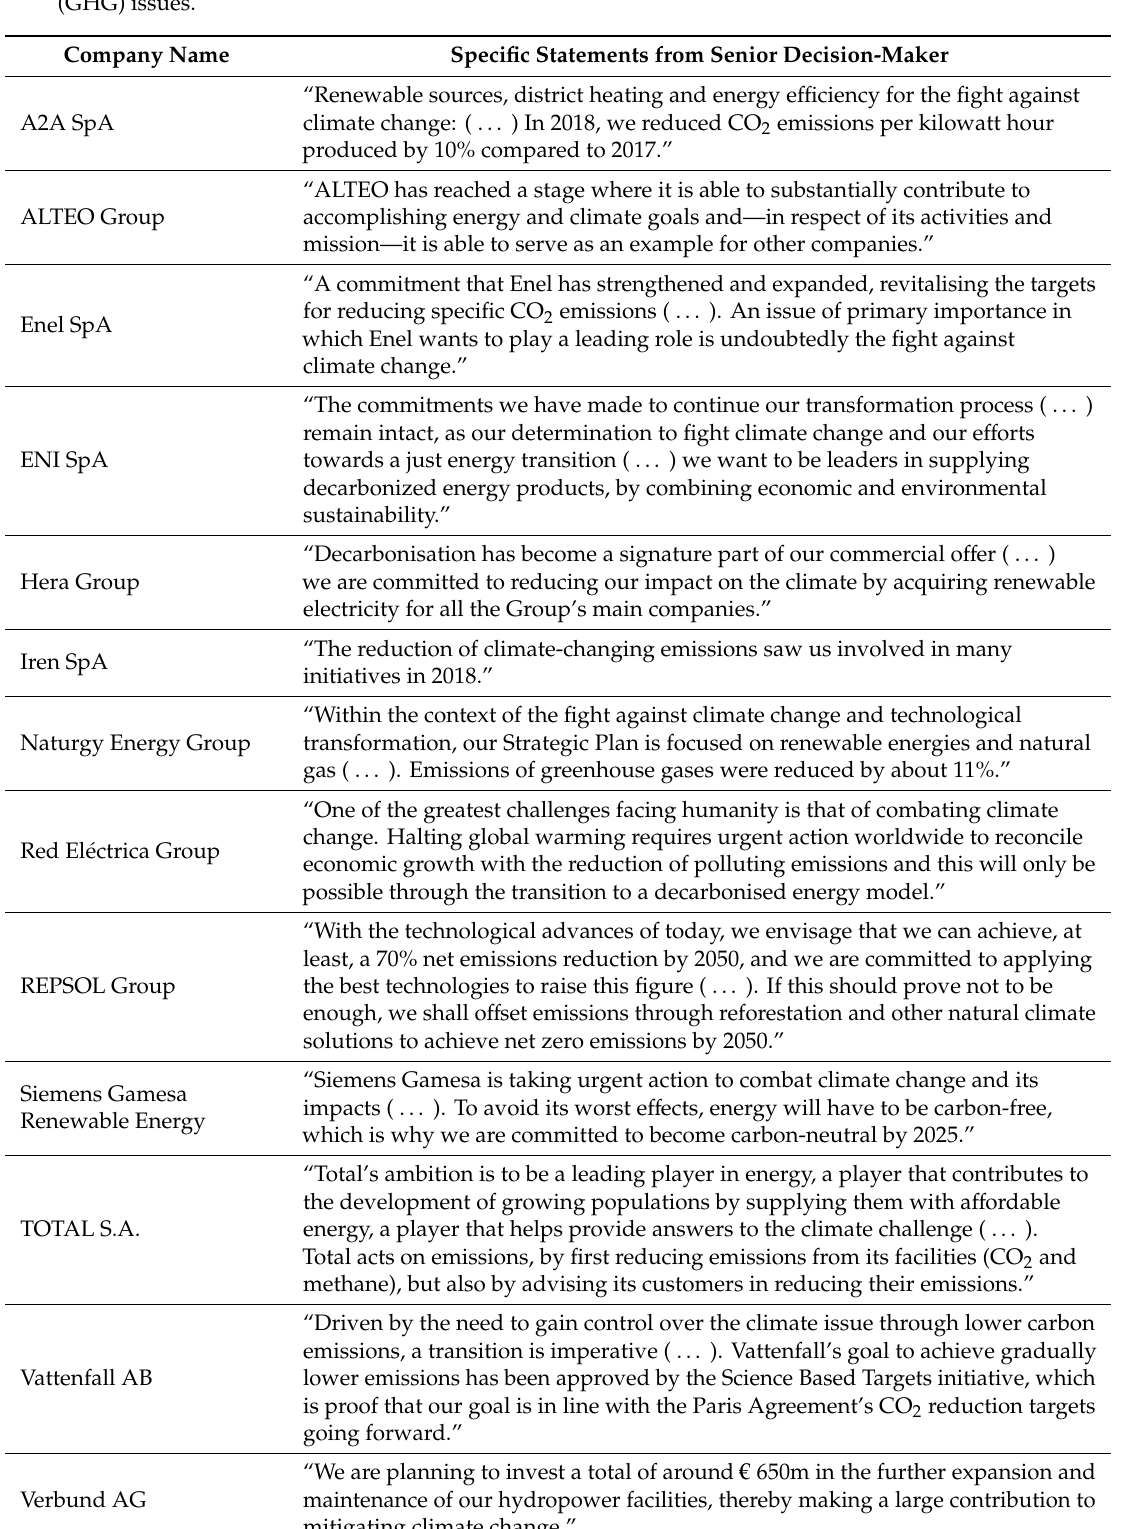
Table 1. Examples of statements from senior decision-maker in relation to greenhouse gases (GHG)